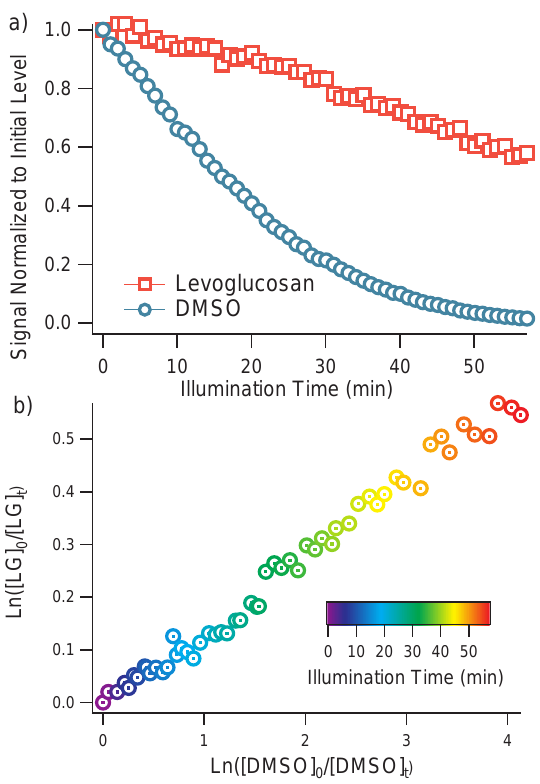
Figure 10. The decay of levoglucosan monitored by the Aerosol ToF-CIMS and the decay of f 60 monitored by the AMS (a) , and the f 60 vs. f 40 trajectory from the current work compared to field measurements (b) . The trajectory obtained in the current work is color coded with irradiation time. The compiled data (Cubison et al., 2011) from field measurements in fire plumes (grey) and non-fire plumes (brown) are also